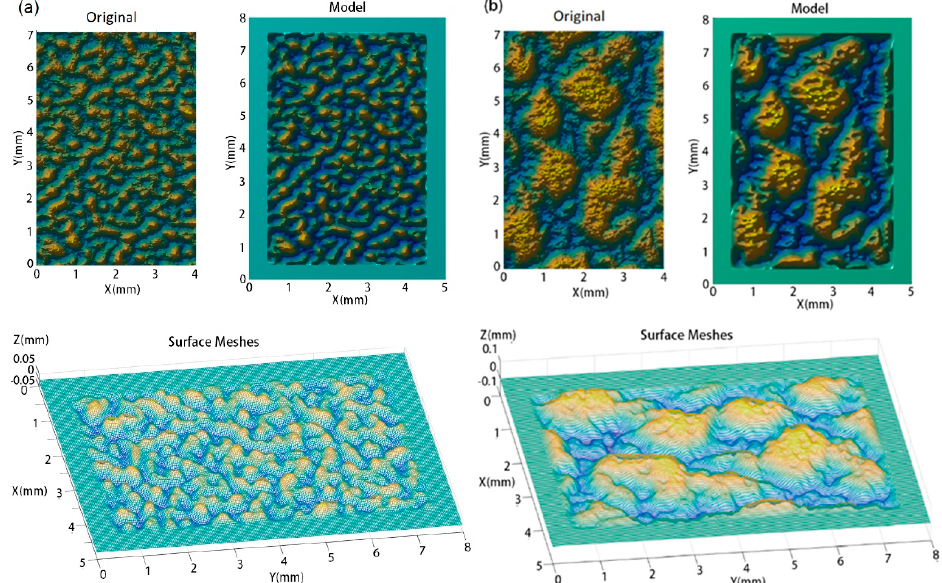
Figure 5. Original sample surface, model, and surface meshes for ( a ) SB texture, and ( b ) CB texture. The original surfaces include all small peaks. The models capture the texture features, small peaks and craters shown in the original surfaces. A 0.5 mm plain margin around the texture was created to extend the plaque model size.